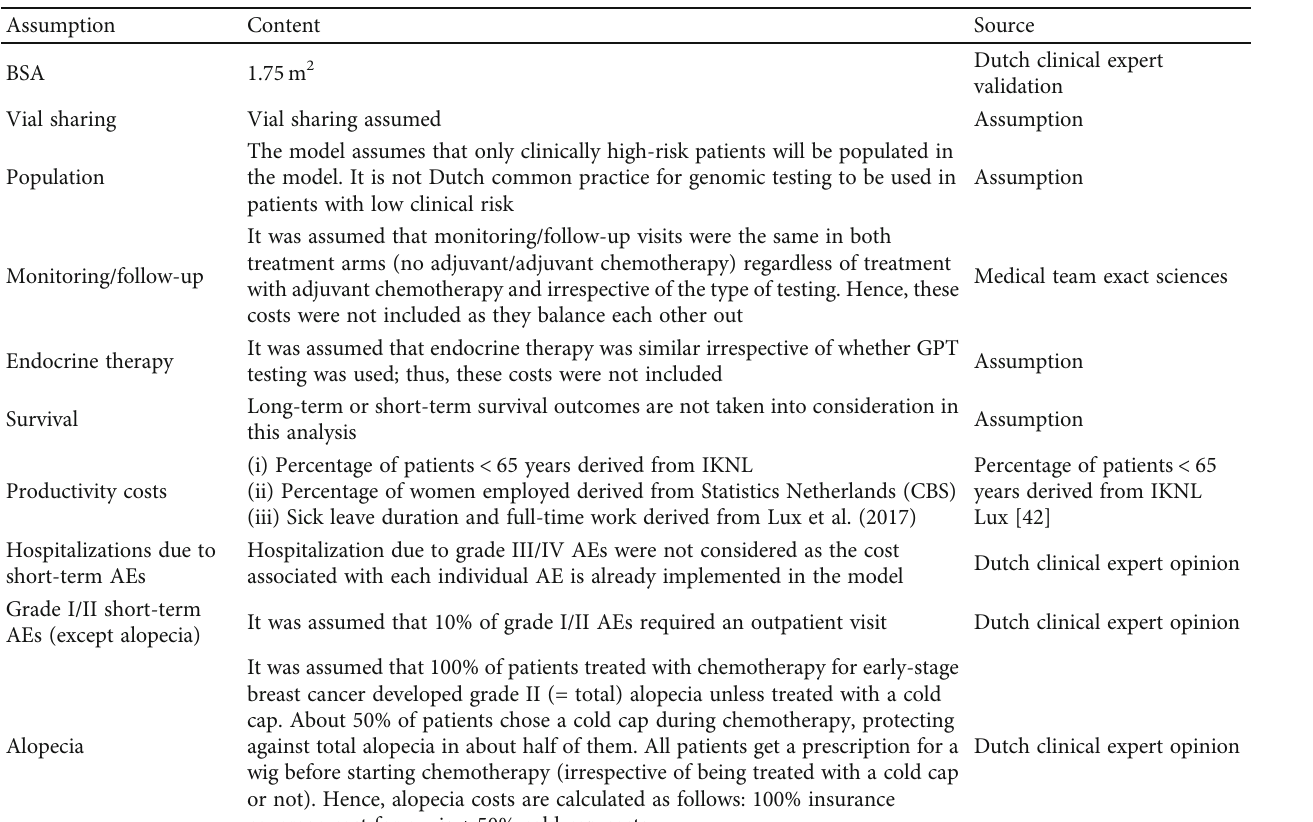
Table 2: The full list of assumptions used in the cost-consequence